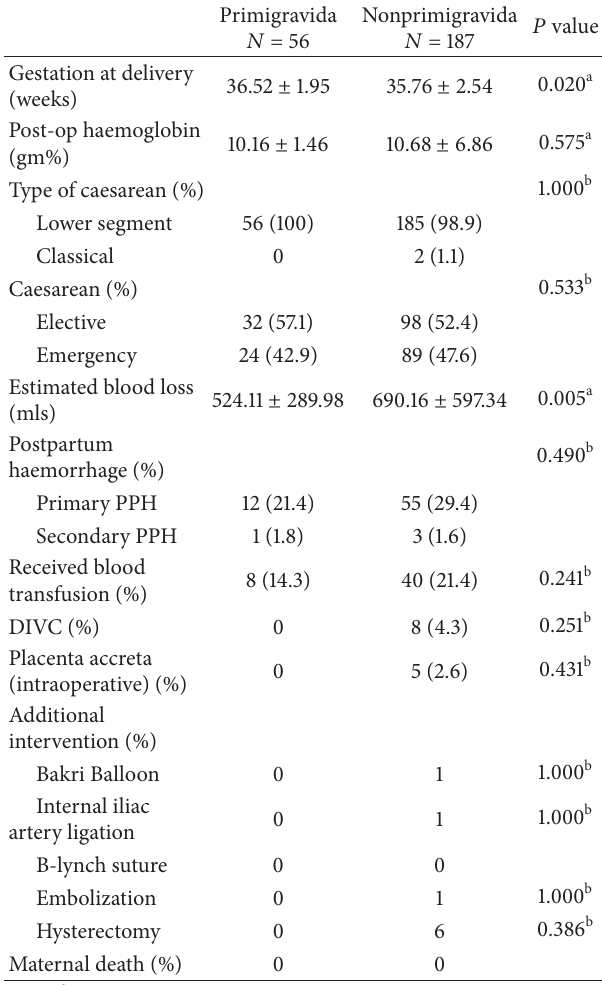
Table 3: Obstetric data in women with major placenta praevia. Table 4: Obstetric outcomes in women with major placenta